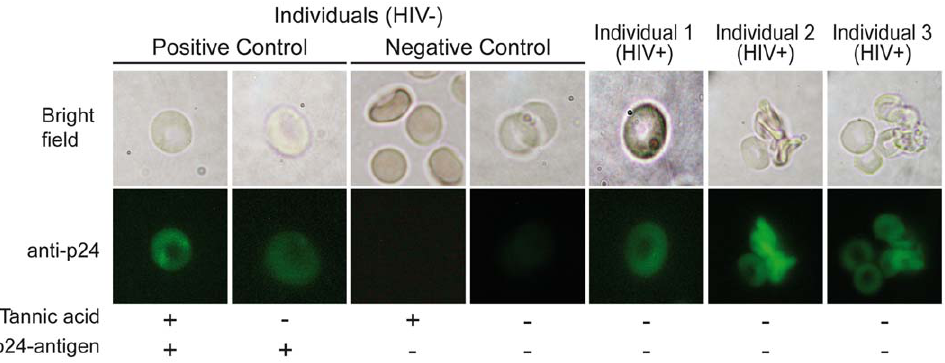
Figure 2. p24-antigen is associated to erythrocyte membrane in HIV-positive individuals. Purified erythrocytes from HIV-negative and HIV-positive individuals were subjected to immunofluorescence with anti-p24 antibody. Homogeneous fluorescence in membrane is observed in purified erythrocytes from HIV-positive individuals (the three images shown are representative of 12 different HIV-positive individuals with plasma viral loads ranging from 1,000 to 20,000 copies/ml). Purified erythrocytes from HIV-negative individuals incubated with p24-antigen alone or p24- antigen plus tannic acid were used as positive control. No positive fluorescence is observed in purified erythrocytes from HIV-negative individuals.